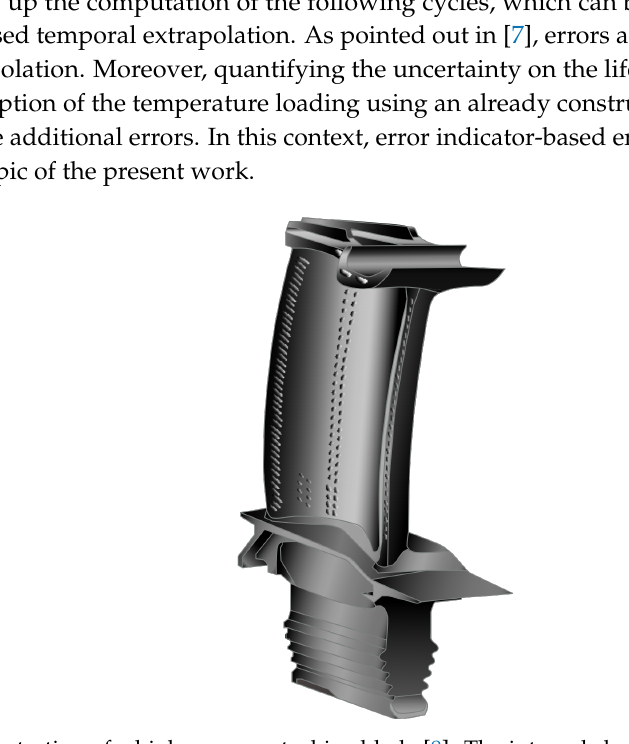
Figure 1. Illustration of a high-pressure turbine blade [8]. The internal channels create a protective layer of cool air to protect the outer surface of the